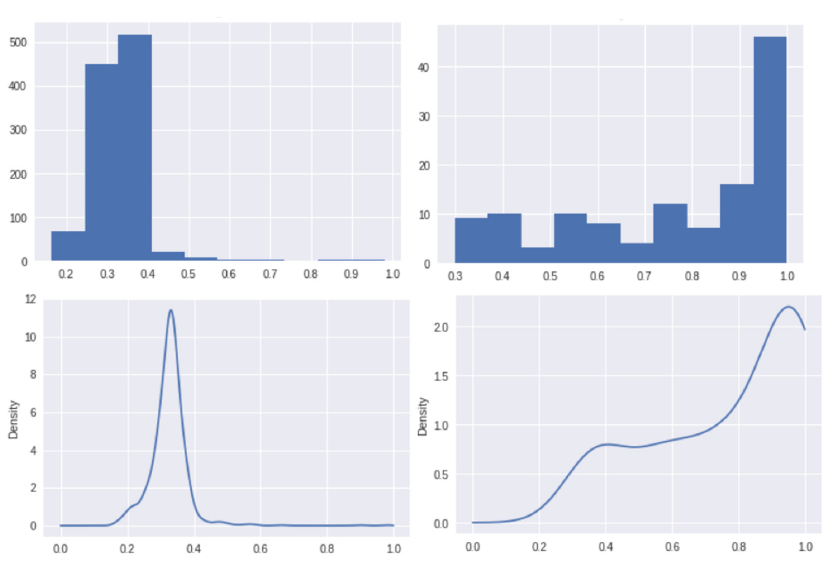
Figure 14. Histograms ( top ) and PDFs ( bottom ) of the classification scores from the validation set of GDXray dataset [24] trained with a patch size of 180.